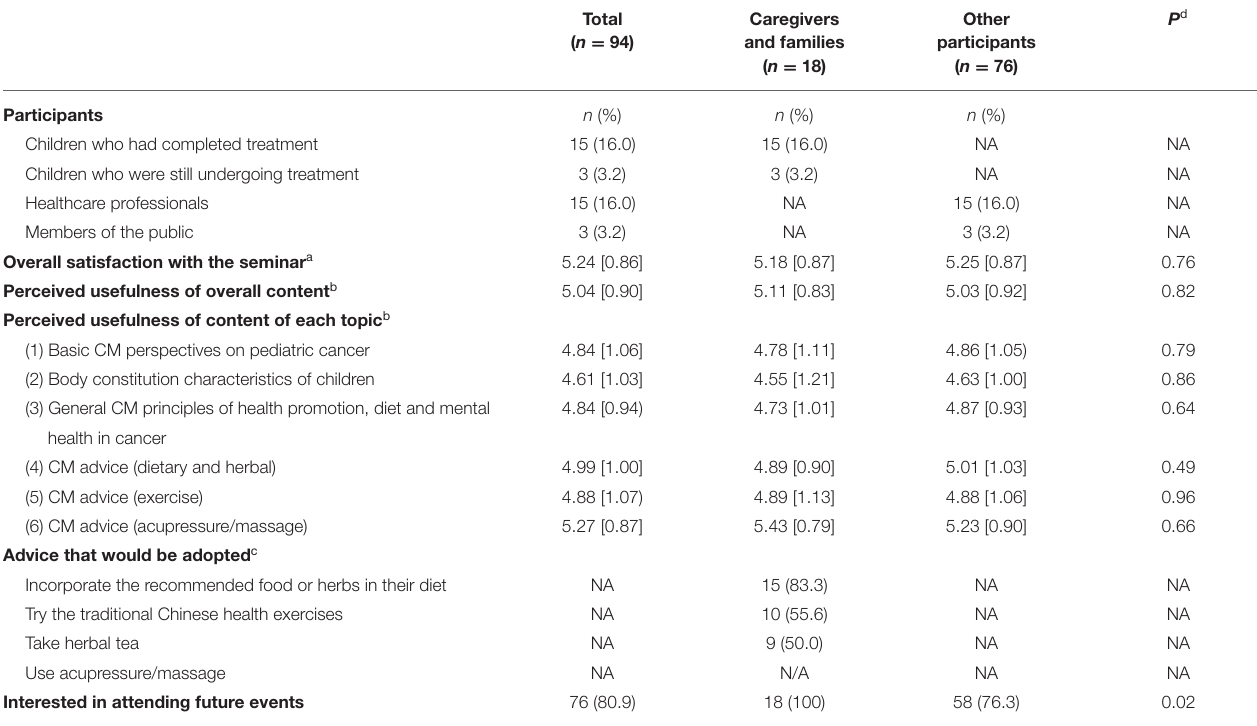
TABLE 1 | Results of the feedback survey of the seminars.